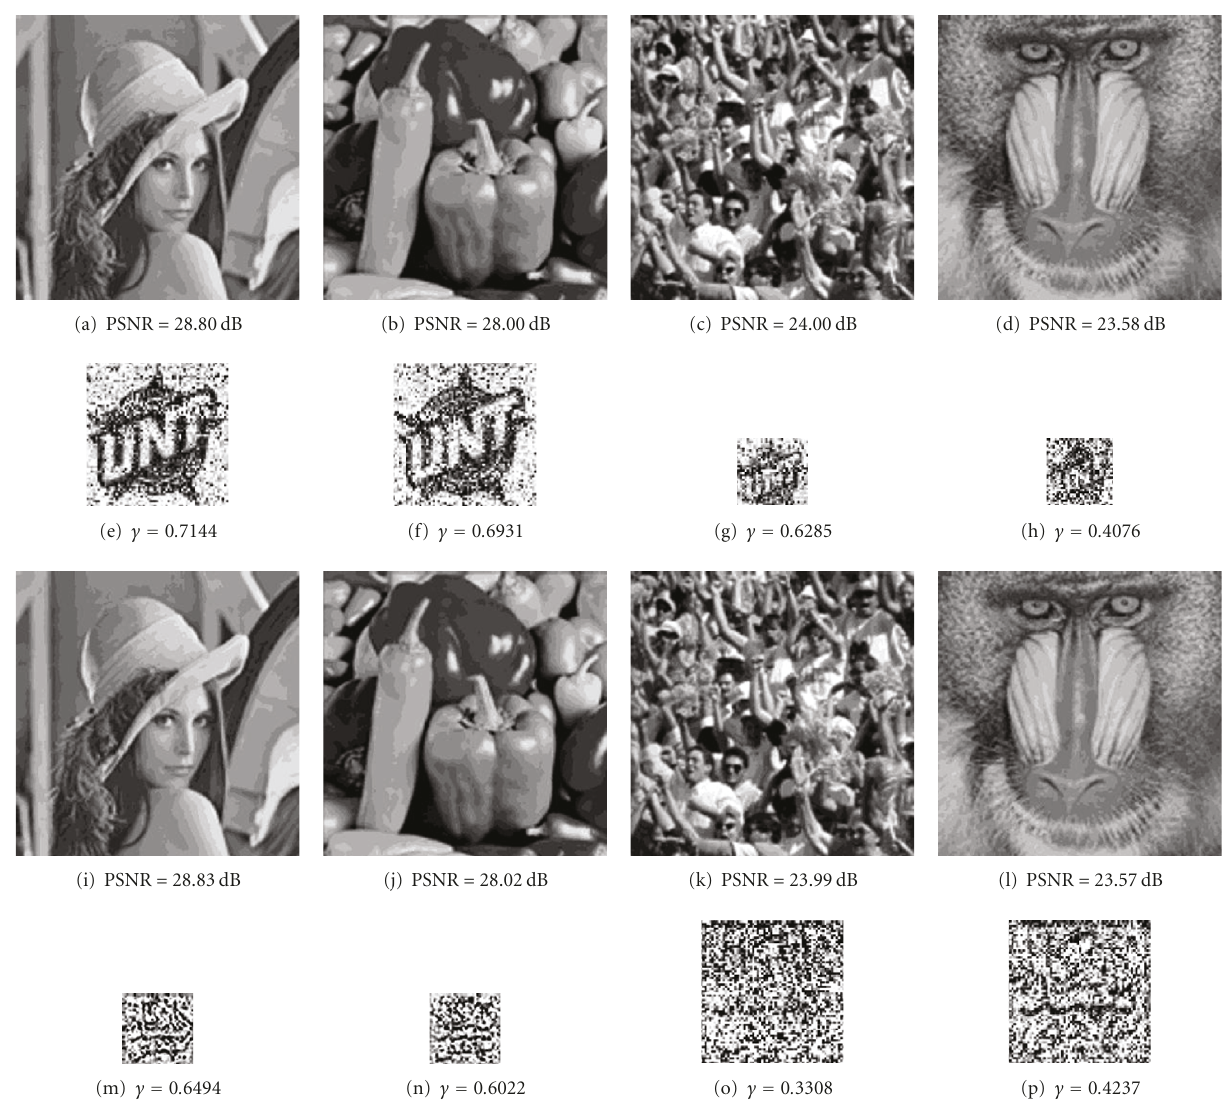
Figure 24: (a) and (b) Lena and Peppers watermarked images with 256 × 256 watermark image as shown in Figure 11(b) after Scaling (1/4), (e) and (f) the extracted watermarks with size 256 × 256 from (a) and (b), respectively. (c) and (d) Crowd and Baboon watermarked images with 128 × 128 watermark image as shown in Figure 11(b) after Scaling (1/4), (g) and (h) the extracted watermarks with size 128 × 128 from (c) and (d), respectively. (i) and (j) Lena and Peppers watermarked images with 128 × 128 watermark image as shown in Figure 11(d) after Scaling (1/4), (m) and (n) the extracted watermarks with size 128 × 128 from (i) and (j), respectively. (k) and (l) Crowd and Baboon watermarked images with 256 × 256 watermark image as shown in Figure 11(d) after Scaling (1/4), (o) and (p) the extracted watermarks with size 256 × 256 from (k) and (l),